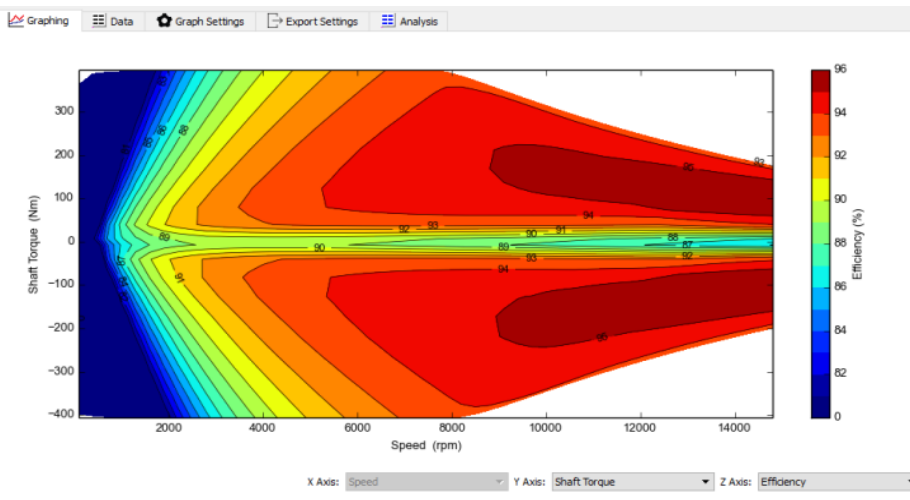
Figure 9. Optimized Efficiency Map of Designed Motor.